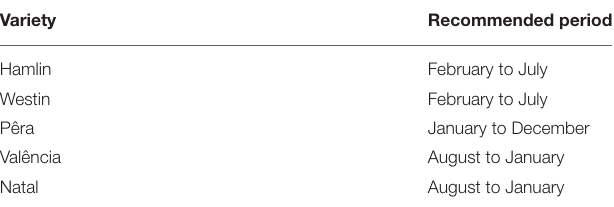
TABLE 2 | Recommendation for citrus fruit borer monitoring according to the citrus variety (Bento et al., 2019).